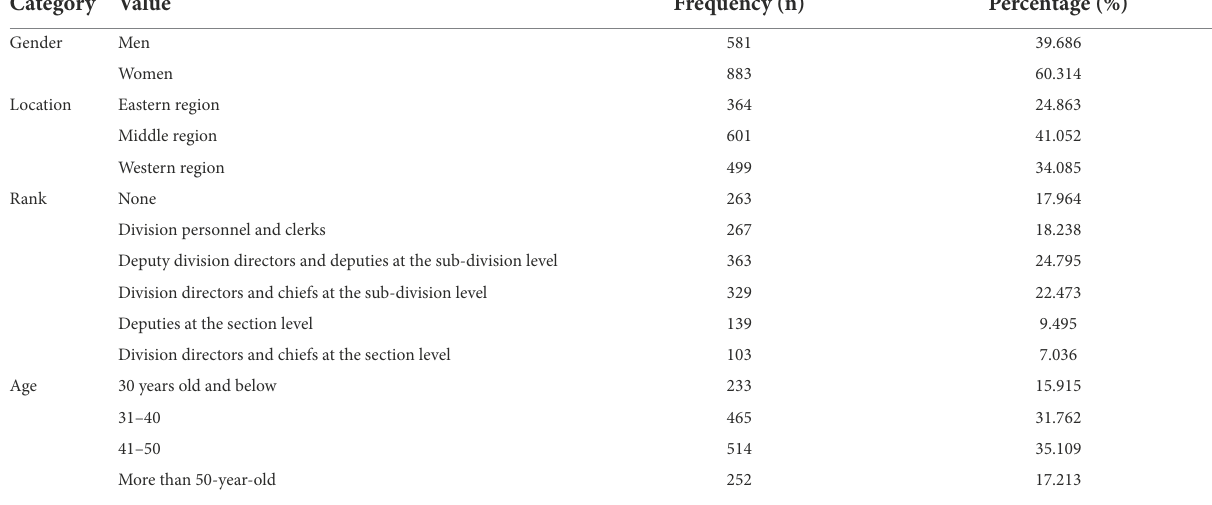
TABLE 2 Description of the sample.